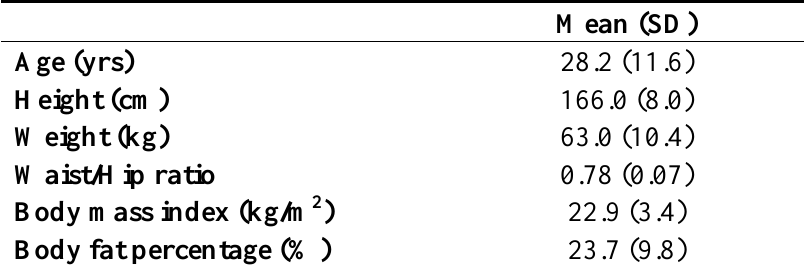
Table 1. Basic data of the subject.